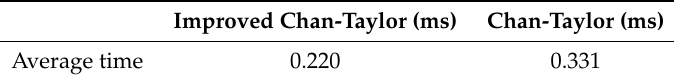
Figure 10. Accuracy comparison between Improved Chan-Taylor alogorithm and Chan-Taylor algorithm. Table 1. Running time of